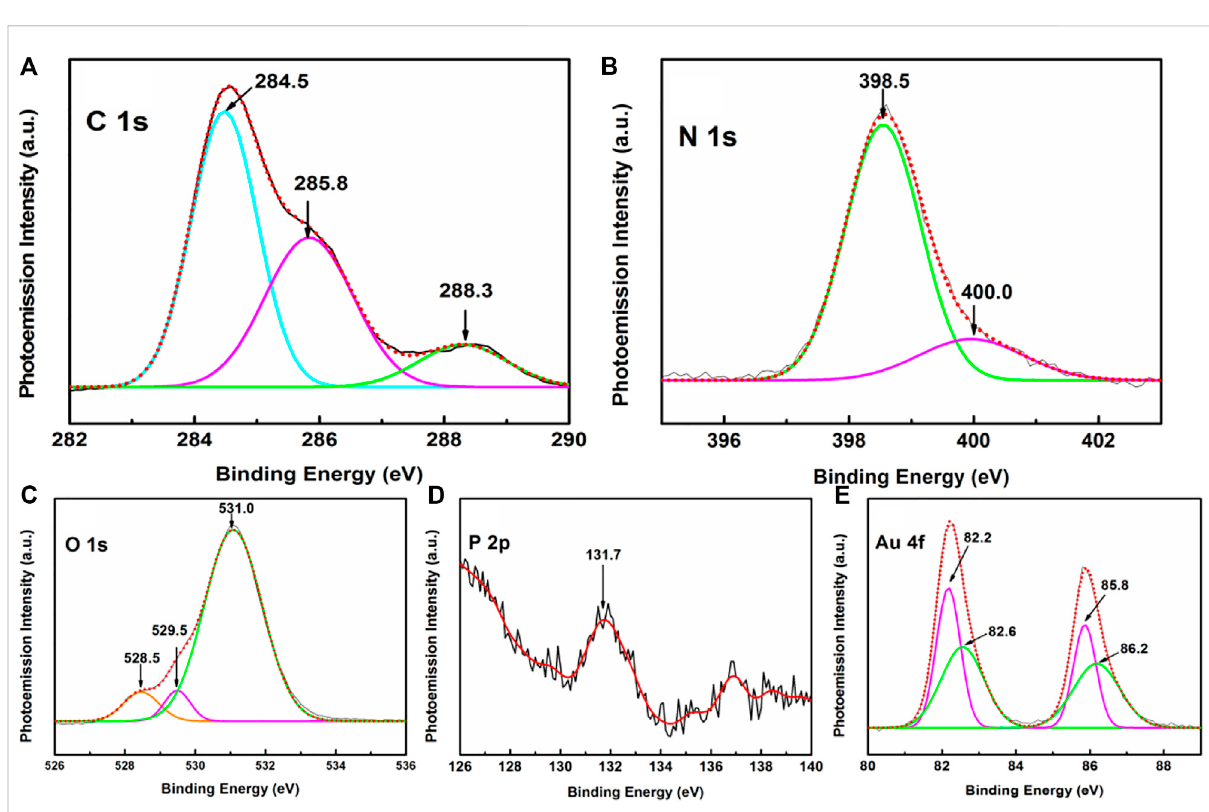
FIGURE 8 Narrow scan XPS spectra of APS focusing on (A) C 1 s, (B) N 1 s, (C) O 1 s, (D) P2p, and (E) Au 4f